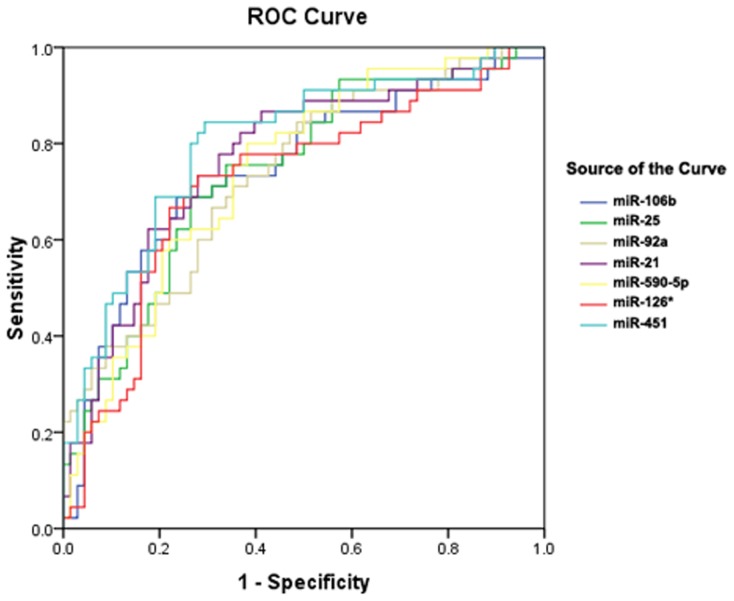
Receiver–operator characteristics (ROC) curves for selected miRNAs in validation cohort.ROC curves regarding diagnostic power to distinguish UA patients from non-UA cases for 7 selected miRNAs in the validation cohort were shown.